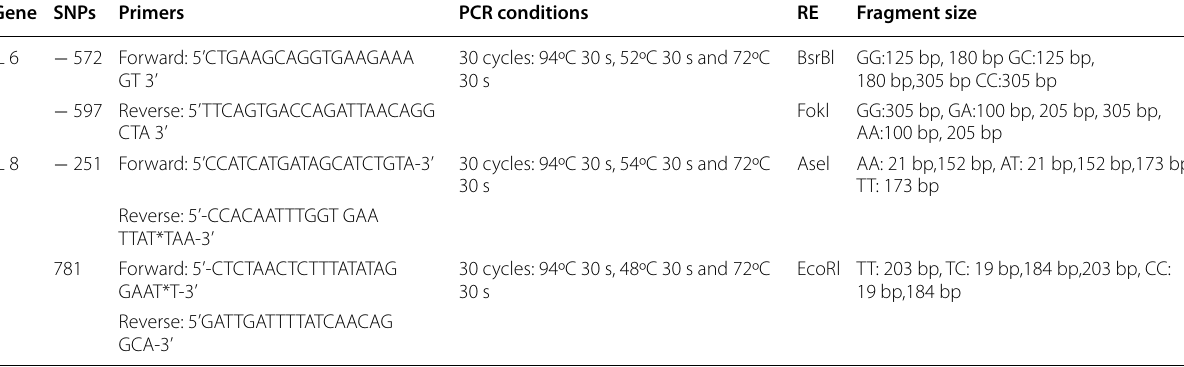
Table 1 Primers and PCR conditions for PCR–RFLP method Gene SNPs Primers PCR